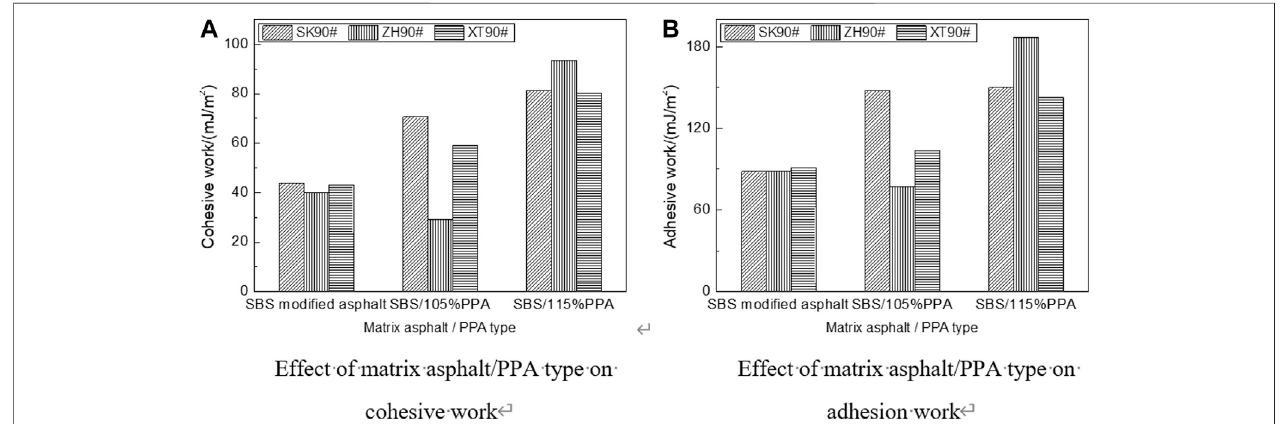
FIGURE4| Effectofmatrixasphalt/PPAtypeonPPA/SBSmodi fi edasphalt ’ sadhesioncharacteristics, (A) Effectofmatrixasphalt/PPAtypeoncohesivework, (B) Effect of matrix asphalt/PPA type on adhesion work.